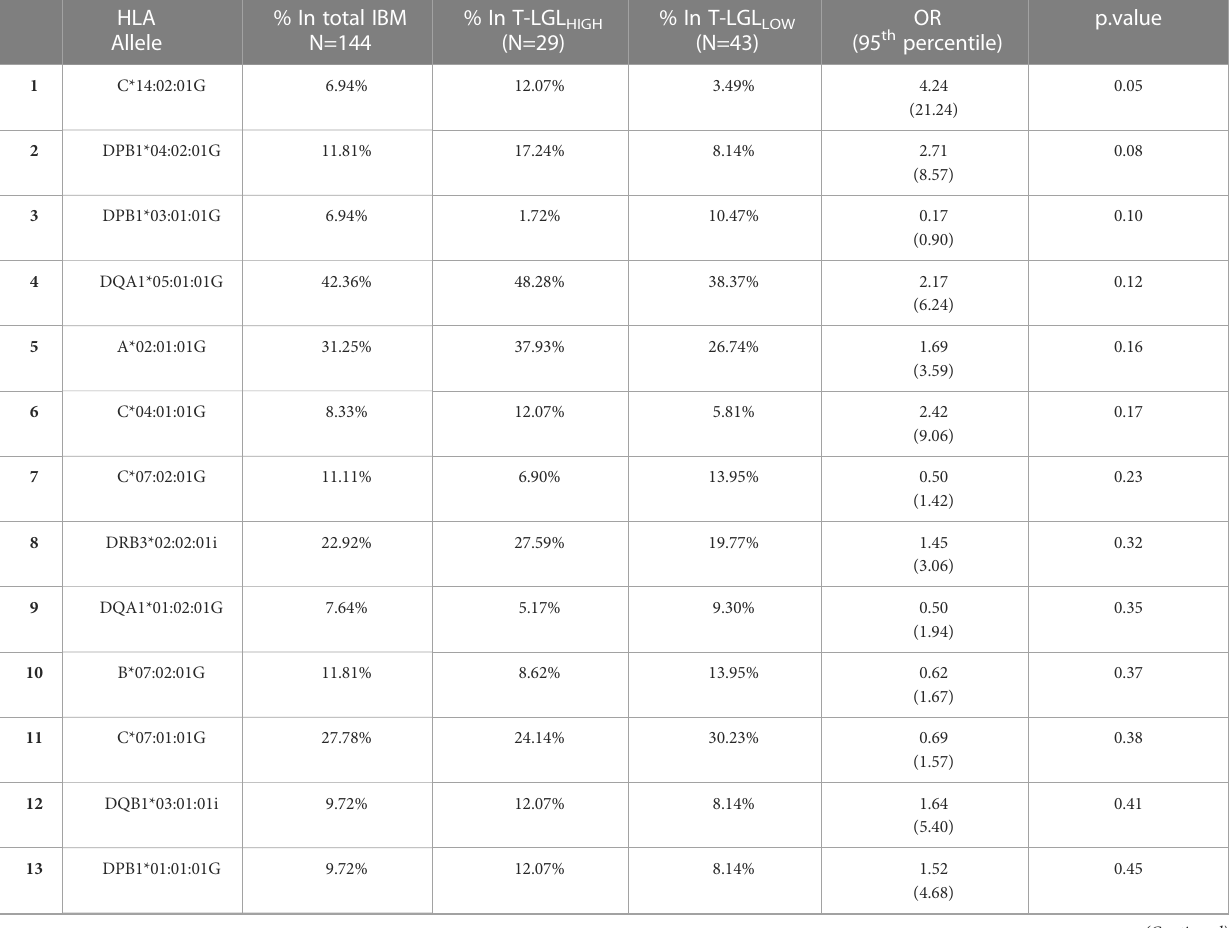
TABLE 3 HLA class I allele frequency in T-LGL HIGH and T-LGL LOW IBM